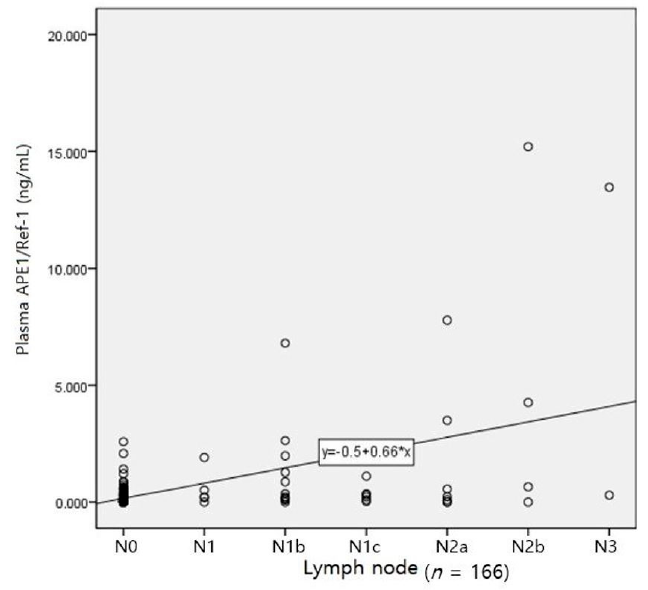
Figure 5. Correlation of lymph node invasion grade and intraoperative plasma APE1/Ref-1 level (immediately after cancer resection).